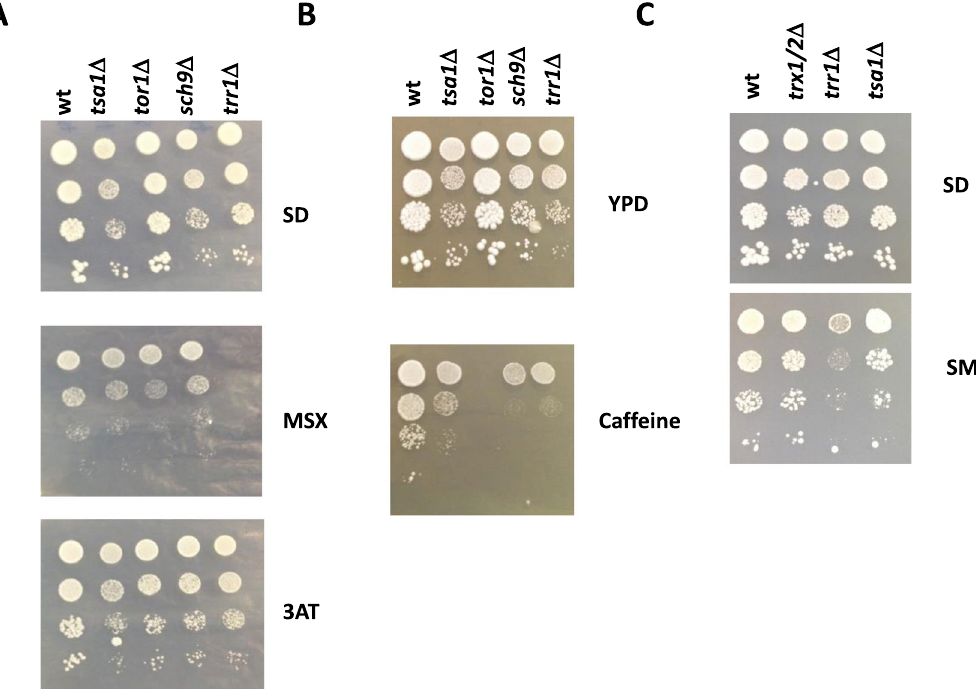
Figure 5. Sensitivity to other inhibitors that cause amino acid starvation. ( A ) The spot analysis in the minimal medium SD that contained methionine sulfoximine (MSX,100 mM) and aminotriazole (3AT, 10 mMM) of strain C9 and the mutants in genes TRR1 , TSA1 , SCH9 and TOR1 . ( B ) The spot analysis of tolerance to 10 mM caffeine on the rich medium YPD of the aforementioned mutants. ( C ) A similar experiment on the SD plates that contained 1 g/ml of sulfometuron methyl